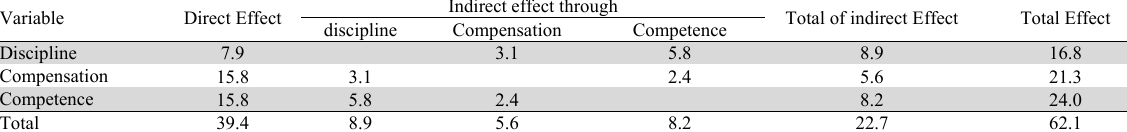
Direct and indirect effects of discipline, compensation and competence toward motivation